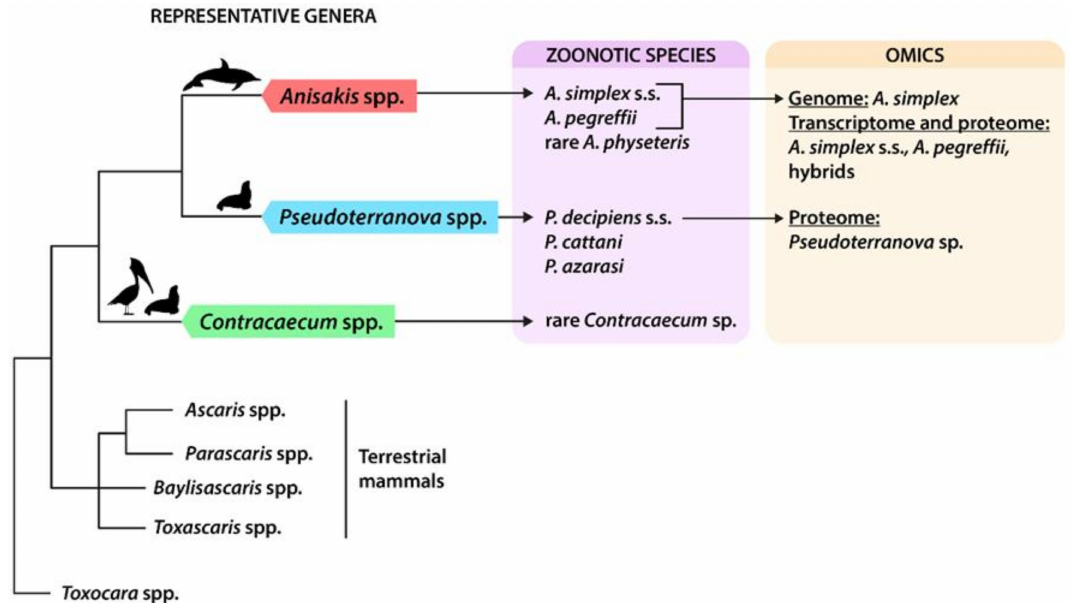
Figure 1. Simplified phylogeny of anisakids, with indications of zoonotic species and available omics data. Simplified phylogenetic relationships of anisakids, modified from the last updated inference based on the entire mitochondrial (mtDNA) [11] can be seen in Figure 1; other phylogenetically related ascaridoids of terrestrial mammals are included as sister groups. Indications of final host a ffi liation for anisakids are reported above the branches (cetaceans, pinnipeds, and fish-eating birds). References of omic studies are reported in the text and in Table